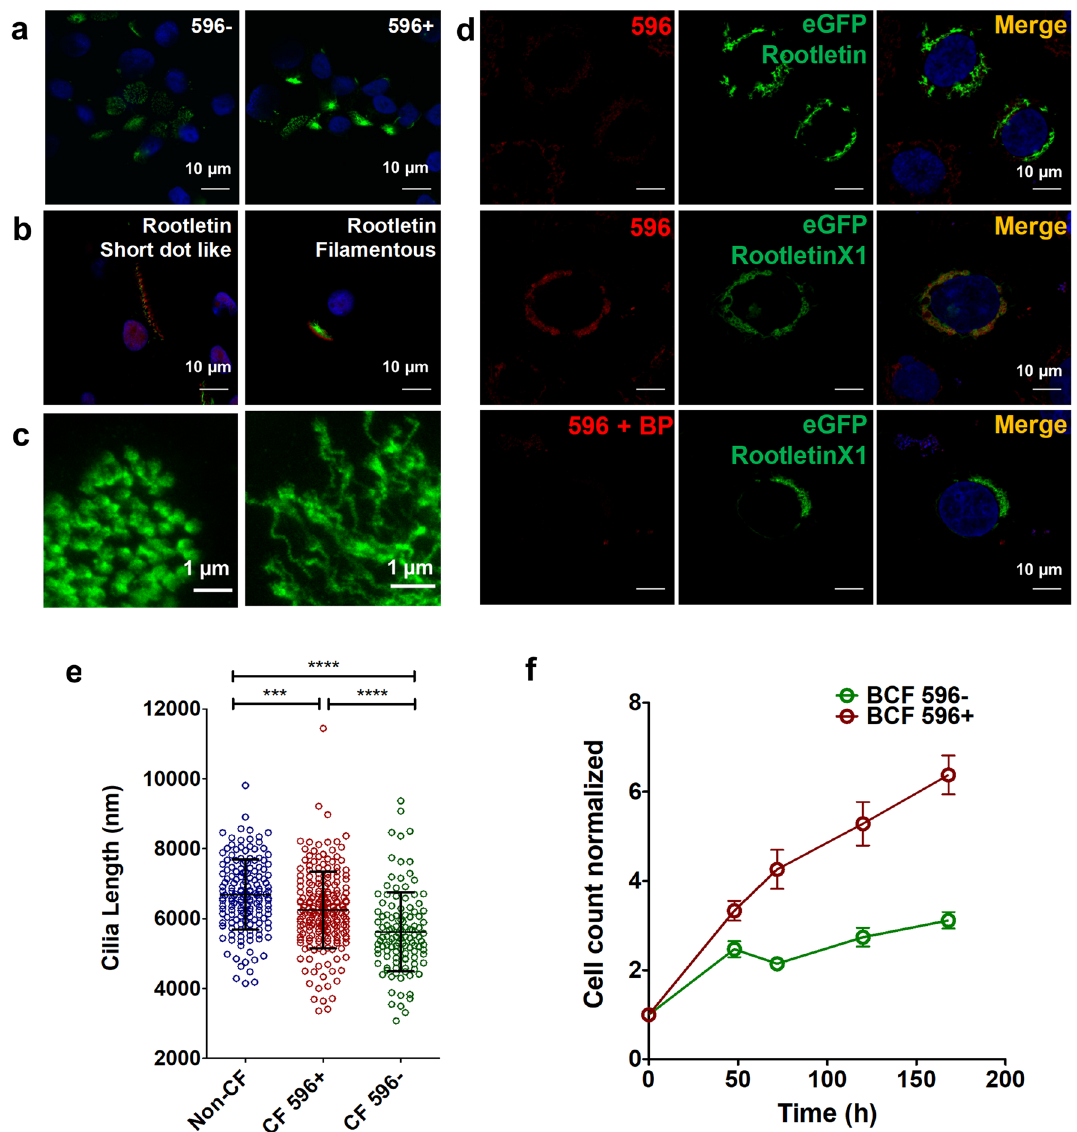
Figure 7. Cross-reactivity of 596 with rootletin and the phenotype of 596- cells. ( a , b ) Immunostaining of 596- (left) and 596+ (right) cells with rootletin antibody. ( c ) STED images of 596+ cells showing both punctate and filamentous rootletin immunofluorescence. ( d ) Confocal images of eGFP-tagged rootletin (lacking WSPGGQML, top row) and the isoform rootletinX1 (which has the pseudo-epitope, middle and bottom rows) expressed in CFBE41o - cells. RootletinX1 was detected using 596 antibody (red) and this immunostaining was abolished by blocking peptide (BP). ( e ) Cilia length in non-CF, 596+ and 596- cells (mean ± SE, n = 119–125, **** p < 0.0001, *** p = 0.0004, one-way ANOVA). Each point represents a single cell. ( f ) Comparison of 596+ and 596- proliferation rates. Each point represents the mean cell count ± SE of 3 independent